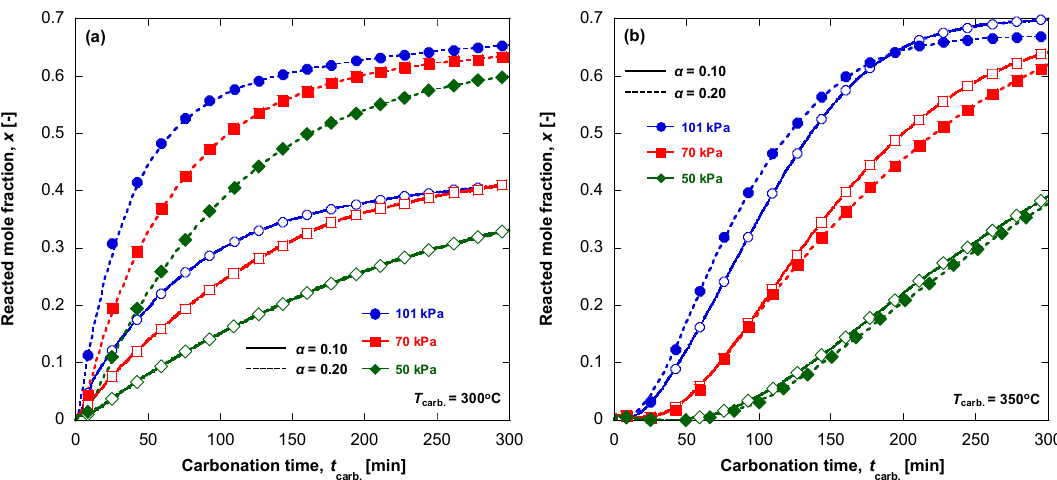
Figure 4. Carbonation dynamics of α = 0.10 (empty symbols) and 0.20 (bold symbols) composite under various CO 2 partial pressure: ( a ) 300 ° C and ( b ) 350 ° C.